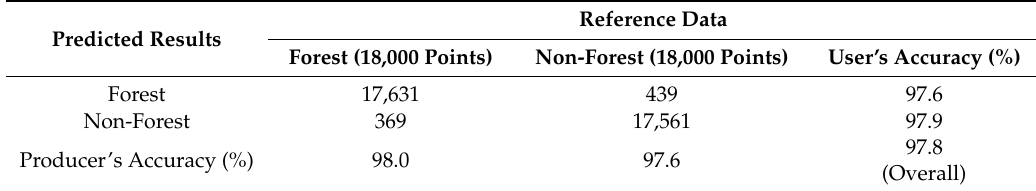
Table 2. Confusion matrix of the newly produced forests and non-forests cover map.